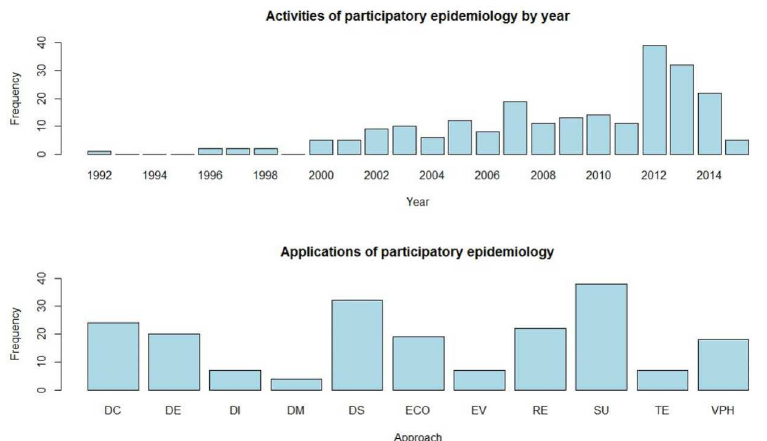
Fig 2. Number of participatory epidemiology activities by year and applications. DC: Evaluation of diseasecontrol methods; DE: Descriptive epidemiology; DI: Disease investigation and diagnosis; DM: Diseasemodelling;DS: Disease survey and prioritization; ECO: Economicor livelihoodimpact of disease; EV: Evaluation of veterinary service delivery; RE: Research; SU: Surveillance;TE: Training; VPH: Veterinary Public